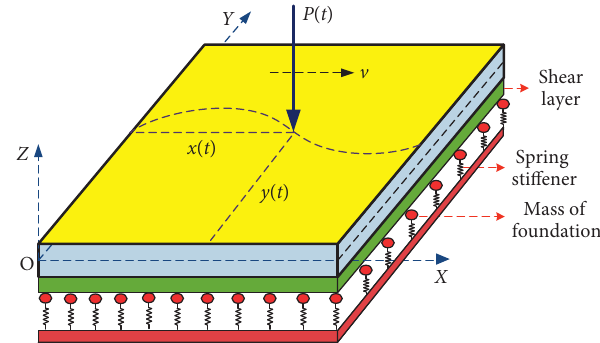
Figure 1: The FGP plate resting on the EFTIM subjected to a moving